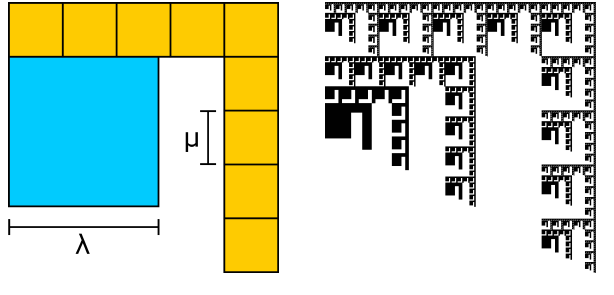
Figure 1: First and fourth iterations generating a self-similar (1/ s ) -Hölder curve Γ in R 2 with 0 < H s ( Γ ) < ∞ ; adjusting λ ∈ [0, 1 − µ ] and µ = 1/ k (where k ≥ 2 is an integer) yields examples of every dimension s ∈ (1, 2]